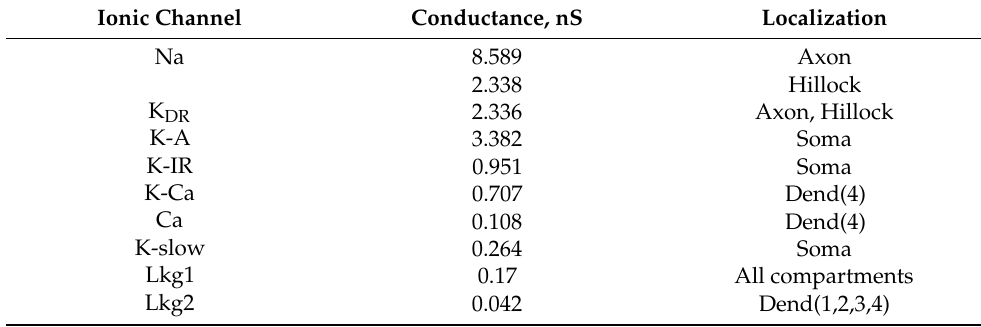
Table 1. GrC voltage-dependent